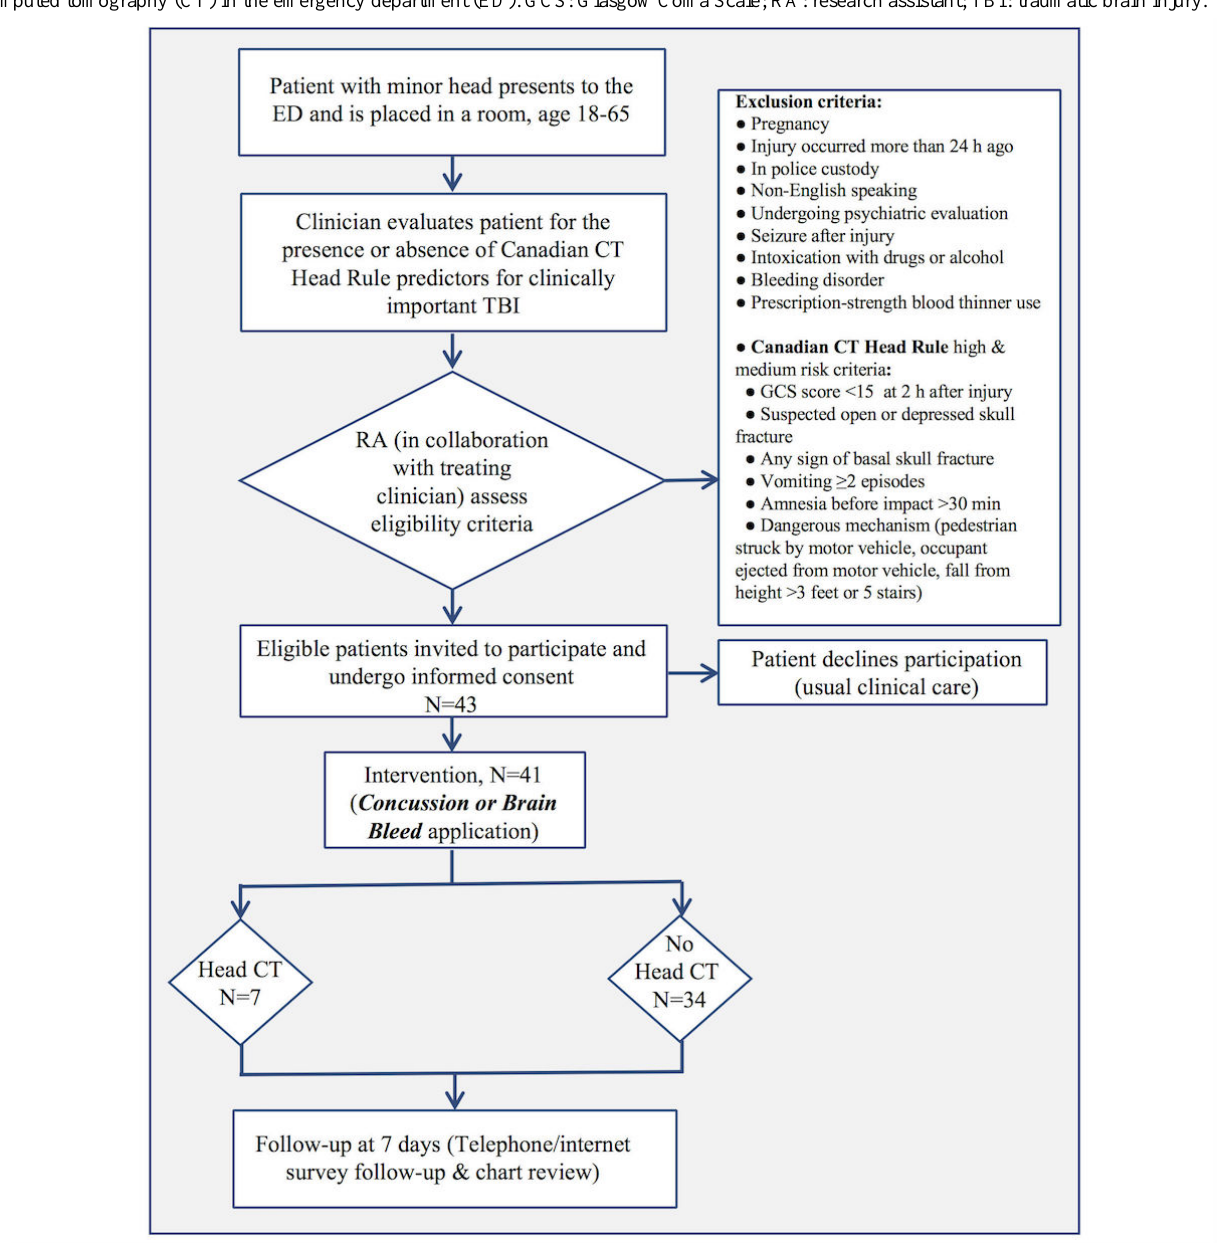
Figure 3. Flow diagram for patient identification and enrollment in the flow of patient care with number of patients identified, enrolled, and